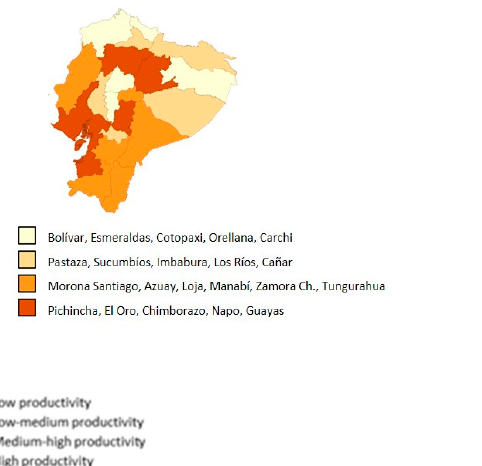
Figure 3. Quantiles of the Sectoral Growth Rate 2007, 2012, and 2017. Source: Own elaboration based on the Regional Accounts of the BCE (2017) [46], and ENEMDU Surveys from the INEC [47] (several years).